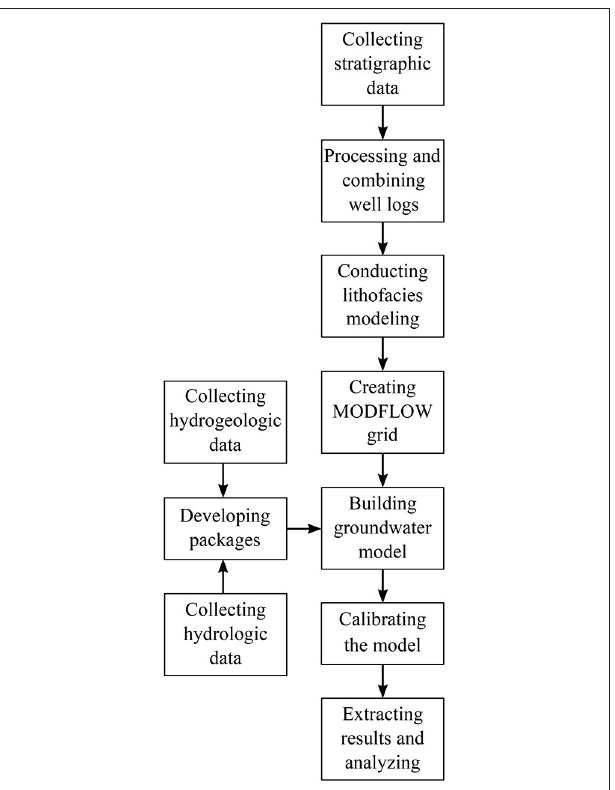
FIGURE 6 | A flowchart of groundwater model development with stratigraphy data, hydrogeologic data and hydrologic data.